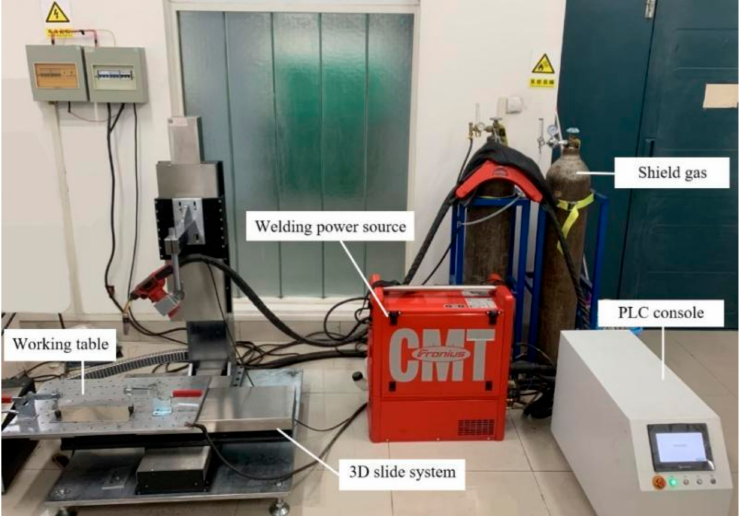
Figure 1. The cold metal transfer wire arc additive manufacturing (CMT-WAAM) system.